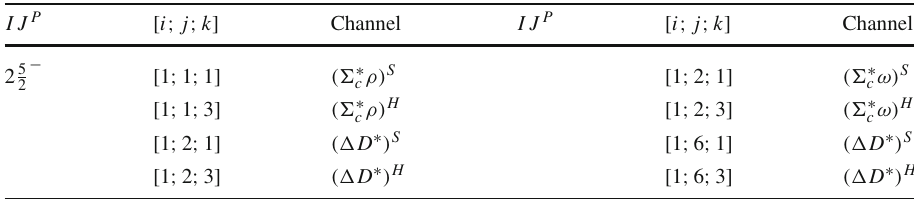
two rows are energies of the channel coupling calculation and the percentages of dominant channels. For the chan- nel coupling calculation, the corrected energy is given as (cid:25) ( Exp .) − E i ( T heo .) ] , where p p i [ E i E (cid:6) = E + i is i th th the percentage of various physical channels. One can see in Table 5 that all physical channels are unbound except the low- est channel of (cid:2) c π in the single channel calculation, which has the binding energy of − 13 MeV. Therefore, a bound state with (cid:2) c π configuration should be considered to exist in this quantum number sector. Nevertheless, (cid:2) c can decay into (cid:4) c and π through strong interaction, so this bound state will appear as a resonance by experimental observation. After correction, the energy of (cid:2) c π state is 2582 MeV, which is close to the (cid:4) c ( 2595 ) with mass M = 2592 . 25 ± 0 . 28 MeV. In fact, the channels of the system influence each other, thus it is necessary to take into account the channel coupling effect. For the channel coupling calculation, the lowest state (cid:2) c π is pushed down about 20 MeV when coupling with other higher channels. After calculation of the composition, we find that the color singlet channel of (cid:2) c π is the main component with the percentage of 90 . 6%, while the hidden color channel of ω and the color singlet channel of N D are the minor com- (cid:4) c ponents, accounting for 6 . 2% and 2 . 2%, respectively. Since the (cid:4) c ( 2595 ) is located very close to the (cid:2) c π threshold,